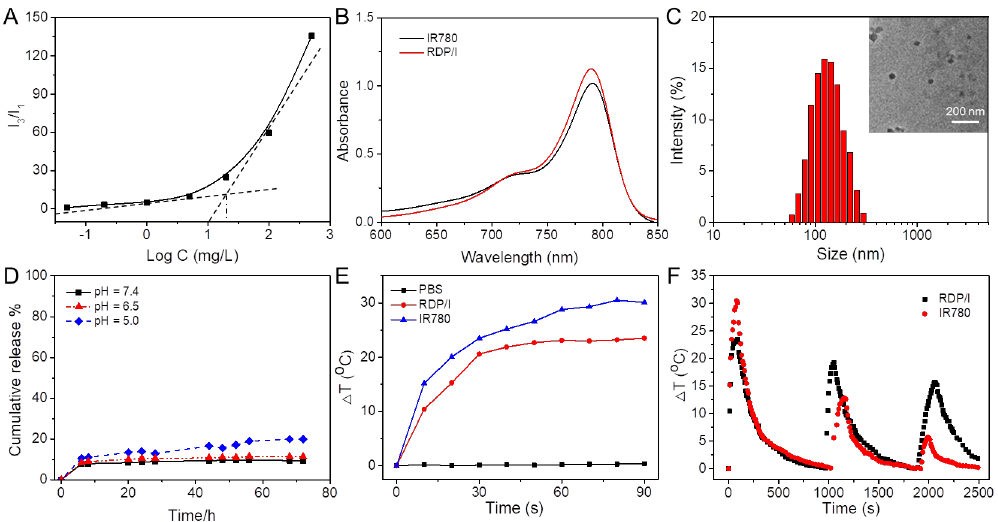
Figure 2. ( A ) The CMC of RDP; ( B ) UV-vis absorption spectra of RDP/I and IR780; ( C ) particle size and TEM image of RDP/I; ( D ) release behavior of RDP/I; ( E ) temperature changes of samples (IR780 concentration was 30 μg/mL) with NIR irradiation (808 nm, 1 W); ( F ) cyclic stability test of samples (IR780 concentration was 30 μg/mL) with NIR irradiation (808 nm, 1 W).